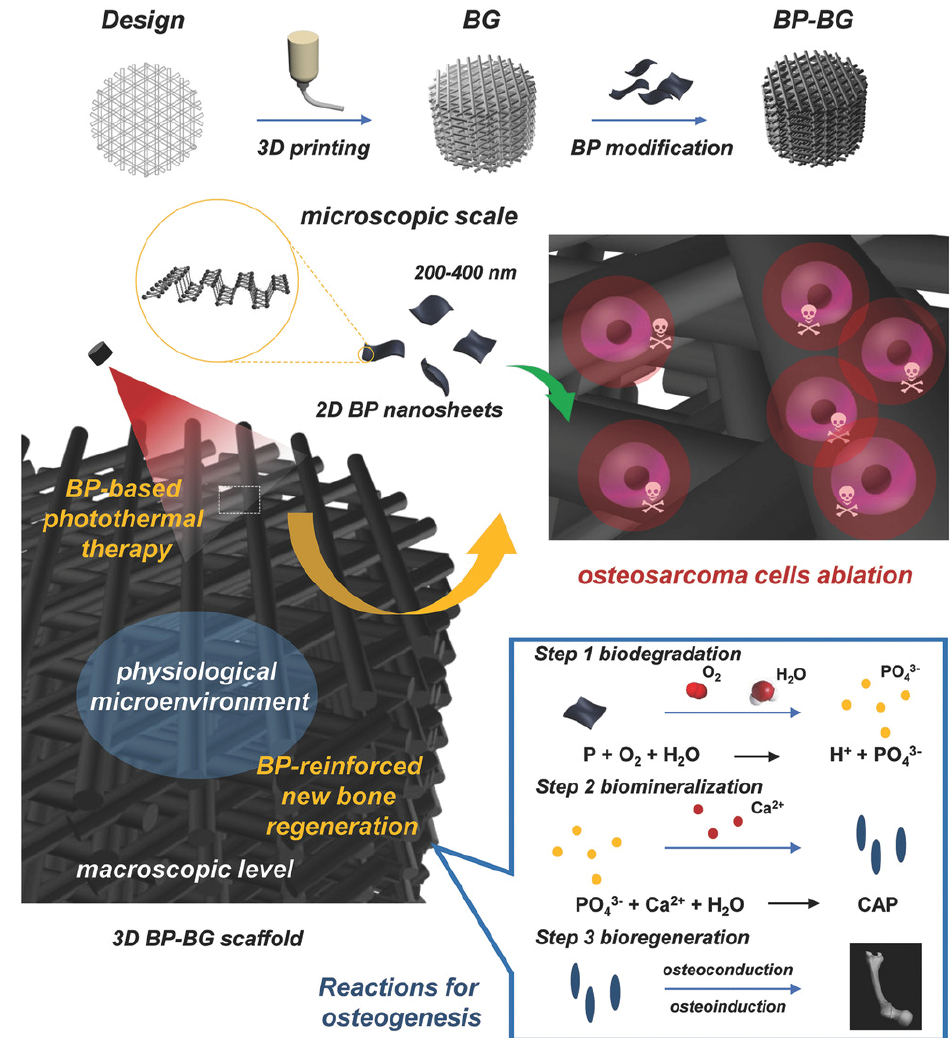
Figure 7. Preparation of black phosphorus − bioactive glass sca ff old and its stepwise treatment strategy for osteosarcoma. Reproduced with permission from [84], Advanced Materials, 2018.